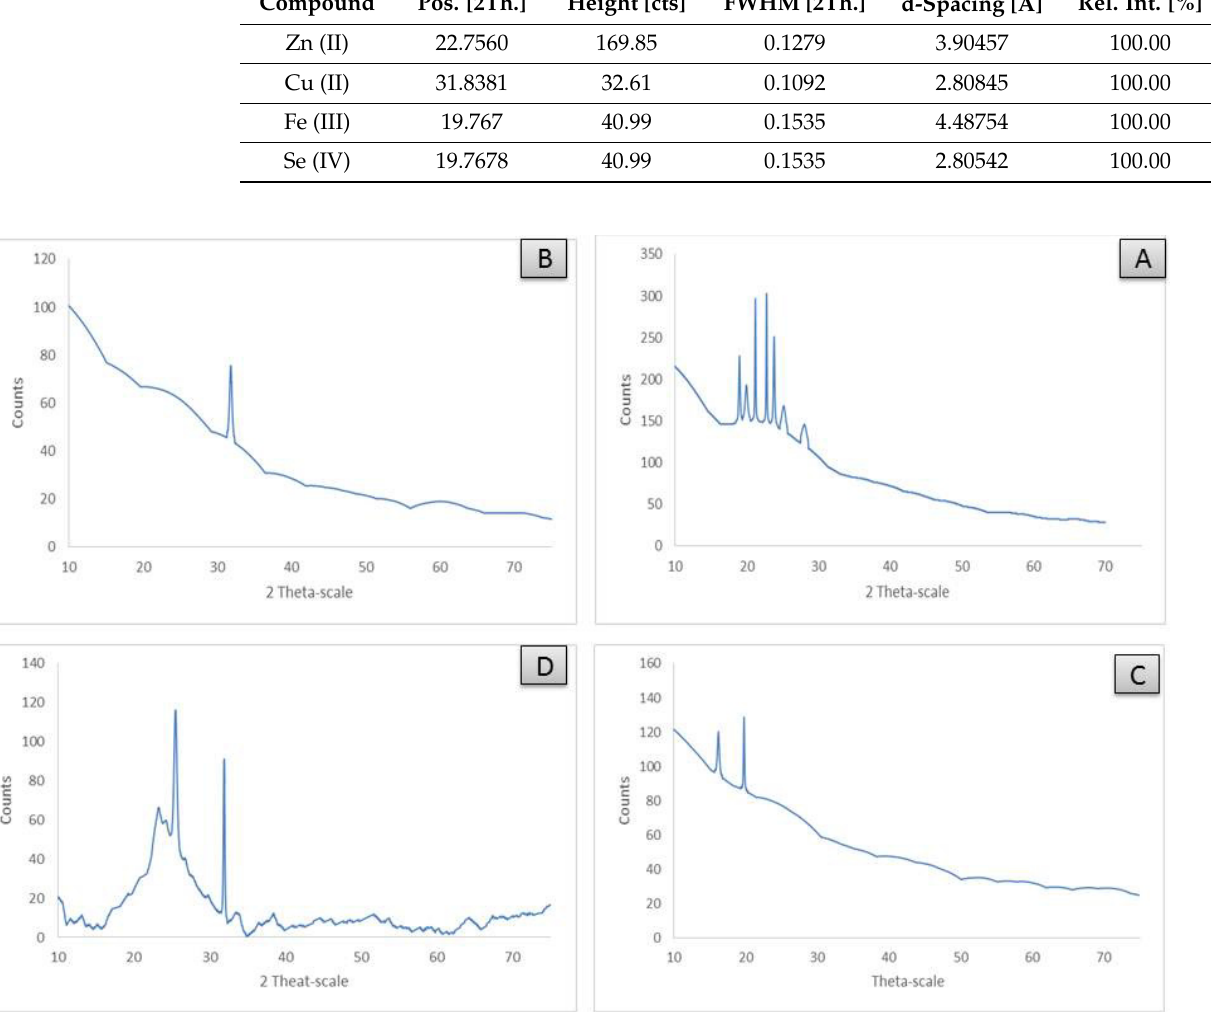
Figure 5. XRD for ( A ): [Zn (CFX) (H 2 O) 2 ]·6H 2 O; ( B ): [Cu (CFX) (H 2 O) 2 ]·3H 2 O; ( C ); [Fe(CFX)(H 2 O) 2 ]·5H 2 O ( D ) [Se (CFX) Cl 2 ]·4H 2